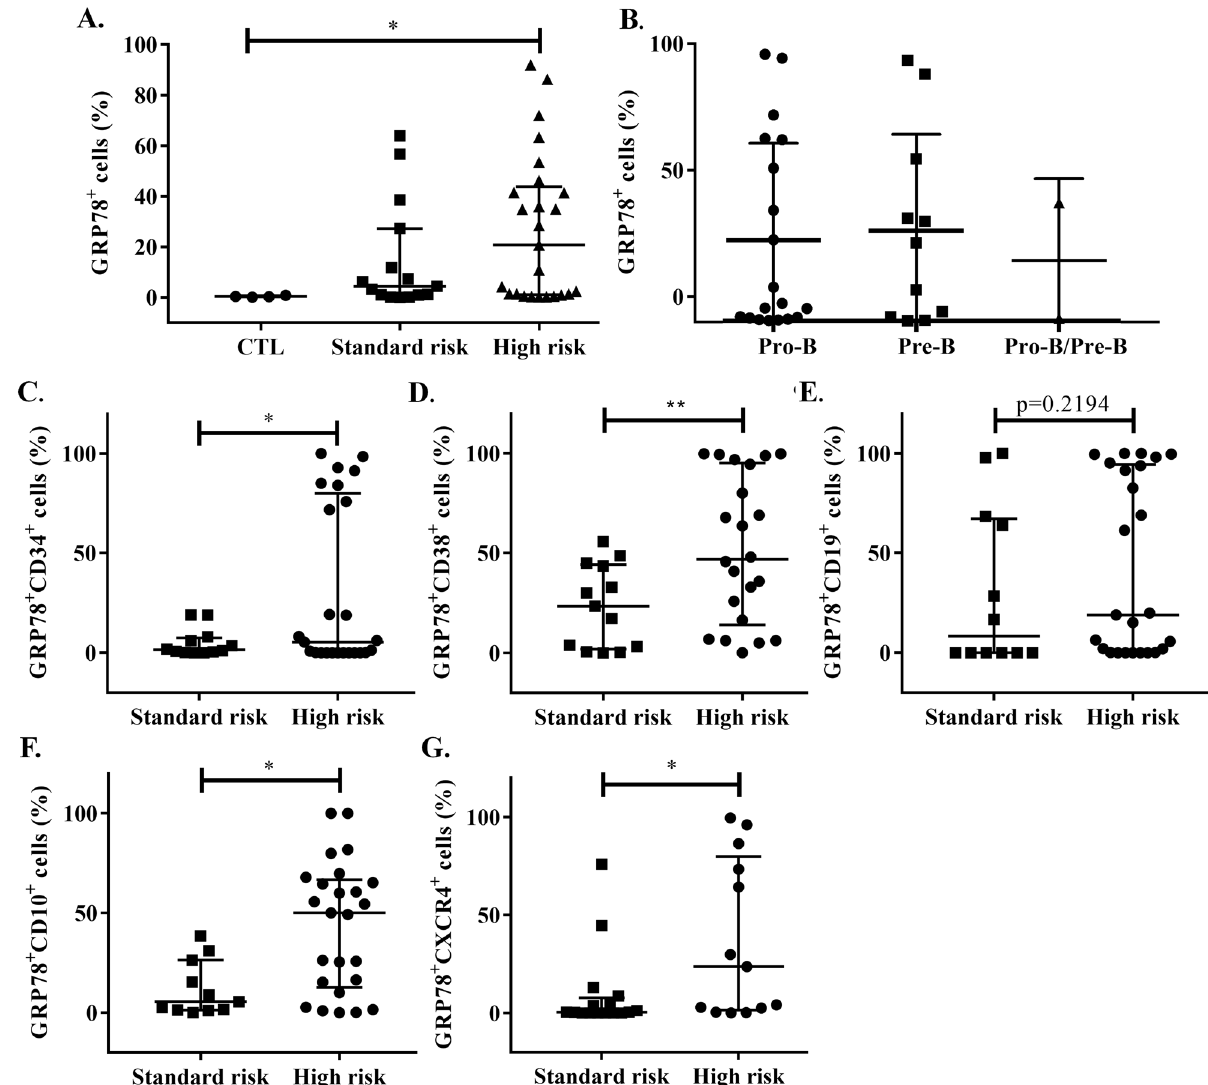
Figure 2. Progenitor and migration markers are associated with GRP78 + cells in High-risk individuals with B-ALL. ( A,B ) Patients were classified by Standard risk and High risk and according to the stage of B-cell development markers, and the percentage of sGRP78 + cells was assessed. Statistical analysis was performed by two-tailed Mann–Whitney U test, *p < 0.01, **p < 0.05. ( C–G ) CD34, CD38, CD10, CD19 and CXCR4 were measured on GRP78 + cells by flow cytometry and the percentages are depicted for both high and standard-risk patients. Statistical analysis was performed by Mann–Whitney U test, *p < 0.01, **p < 0.05, ***p <